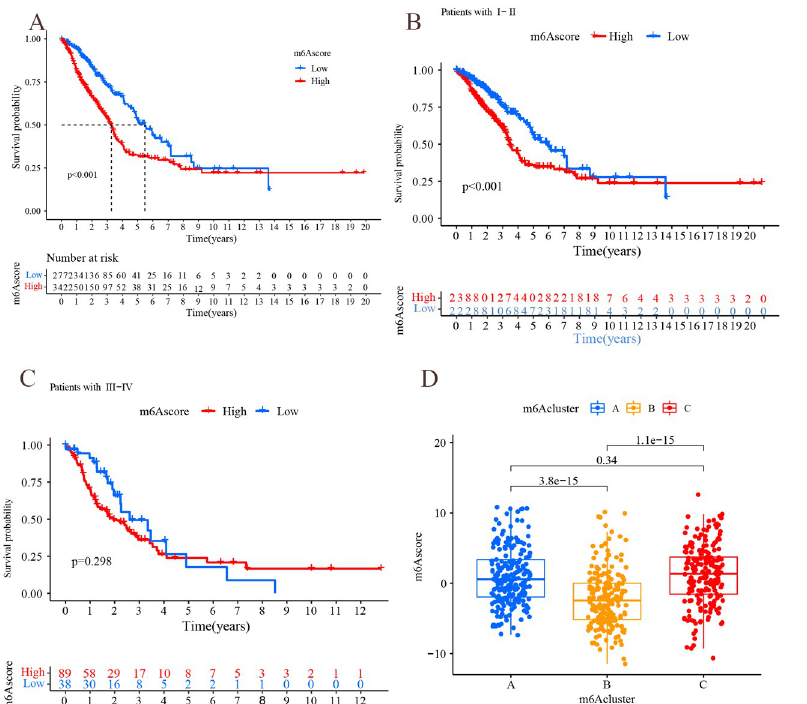
Fig 11. Results of m 6 A score analysis. (A) Survival analysis in m 6 A score subgroup: Horizontal coordinates indicate survival time, vertical coordinates indicate survival rate, red line indicates high m 6 A score group, and blue line indicates low m 6 A score group. (B) Survival analysis in m 6 A scoring groupings(patients with stage I-II): Horizontal coordinates indicate survival status, and vertical coordinates indicate m 6 A score. (C) Survival analysis in m 6 A scoring groupings(patients with stage II-III): Horizontal coordinates indicate m 6 A score, vertical coordinates indicate patient proportion, blue square part indicates survival status, and red square part indicates death status.